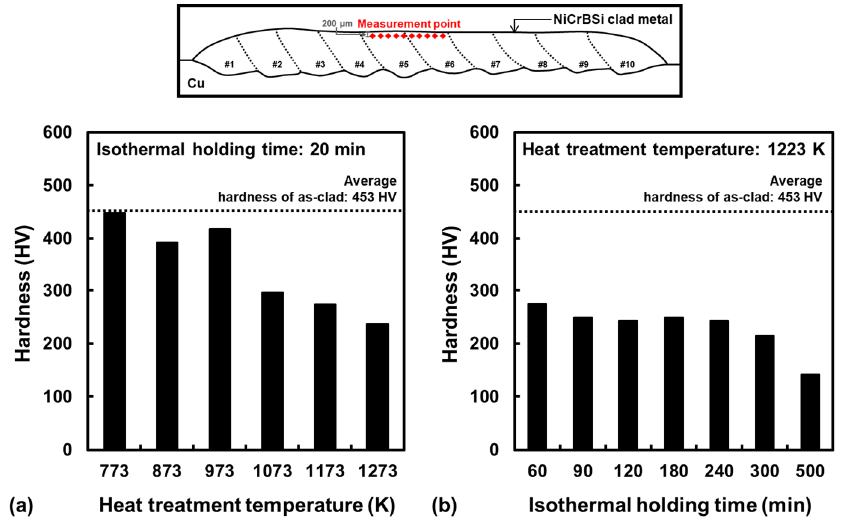
Figure 6. Hardness variation upon post-clad heat treatment: effect of ( a ) heat treatment temperature and ( b ) isothermal holding time.